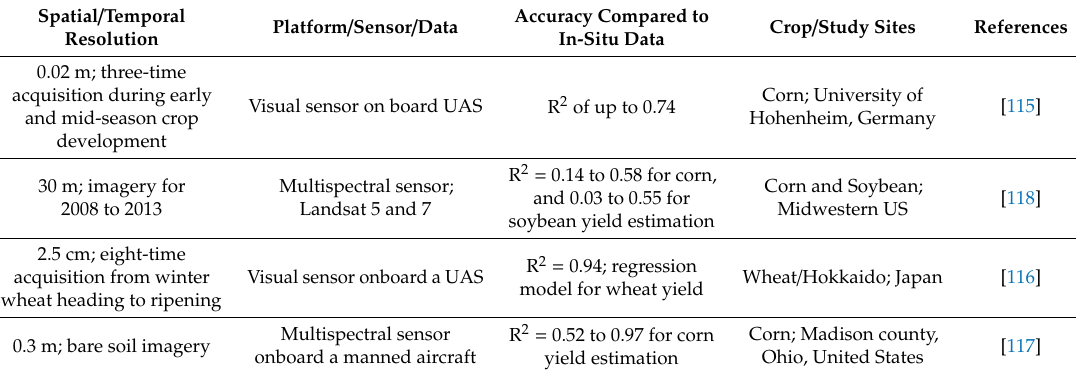
Table 9. Studies conducted for crop yield assessment using RS data.